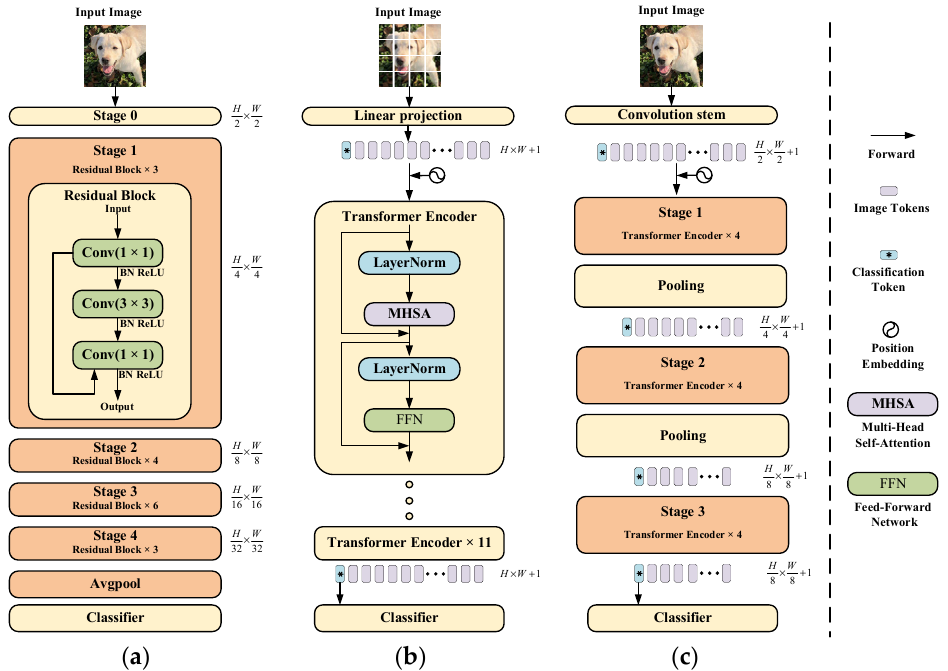
Figure 2. Comparison of three different neural network architectures ( a ) ResNet-50 [21] ( b ) Vision transformer [19] ( c ) Multi-stage transformer [22].